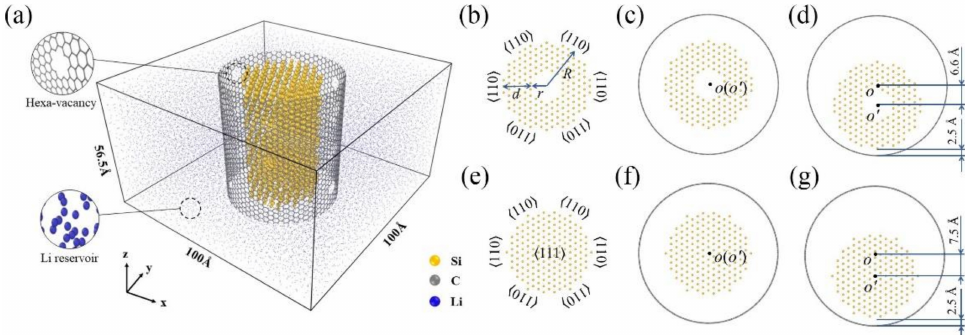
Figure 1. ( a ) Illustration of the reactive force field (ReaxFF)-molecular dynamics (MD) simulation of the lithiation process. Schematic illustration of the cross-sectional shape of ( b ) silicon nanotubes (SiNT) sample, ( c ) concentric carbon-coated silicon nanotube (SiNT@CNT) sample, ( d ) eccentric SiNT@CNT sample, ( e ) SiNW sample, ( f ) concentric SiNW@CNT sample and ( g ) eccentric SiNW@CNT